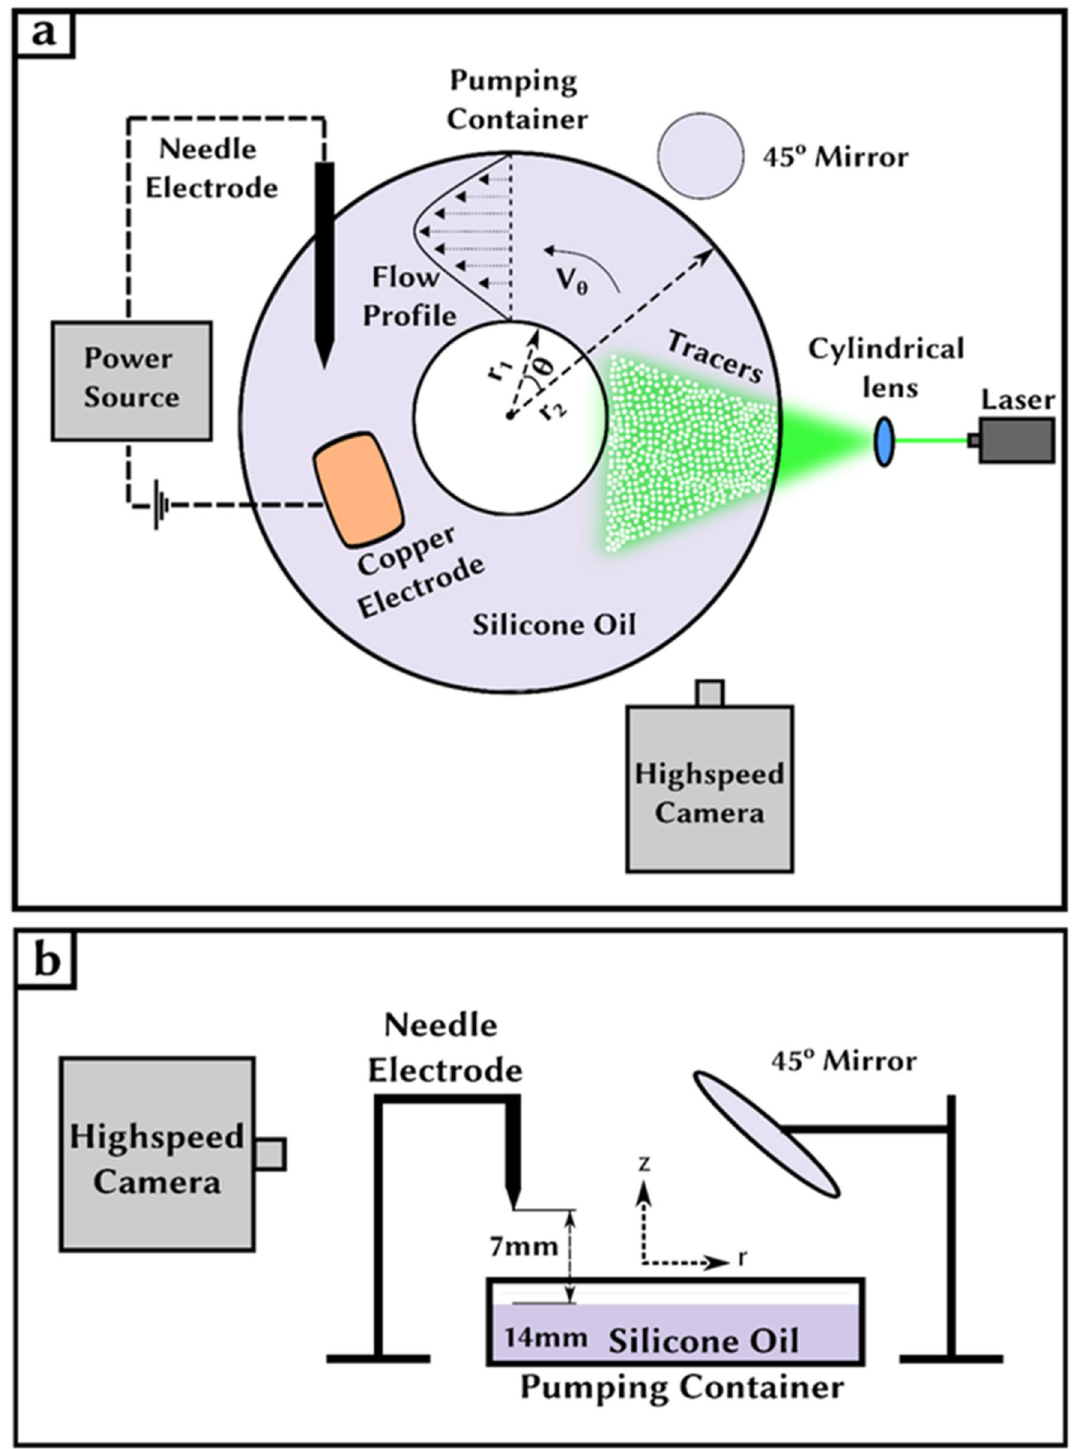
profile and direction, and b showing the side view, for clarification. The needle is 7 mm away from the oil surface, and the oil has a thickness of 14 mm (for all experiments). Schematic is not to